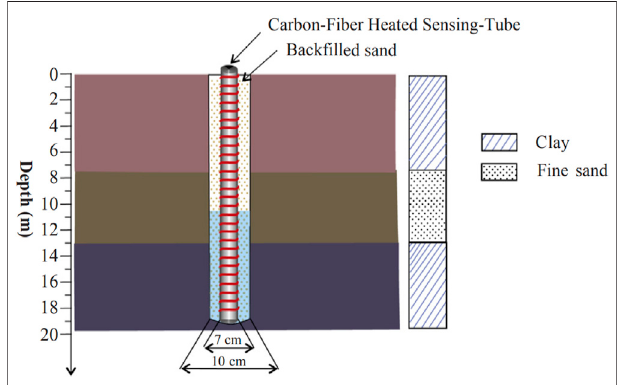
FIGURE 9 | Schematic diagram of CFHST used for soil water content monitoring of a foundation pit in Changzhou (Cao et al., 2018a).